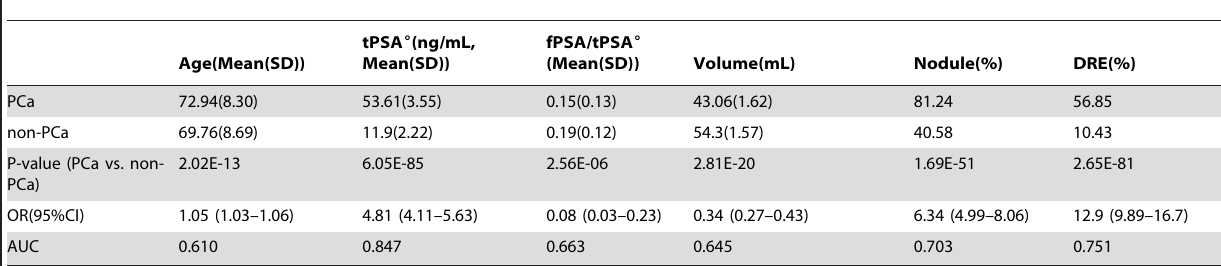
Table 2. Univariate analysis (testing the association between each variable and PCa).